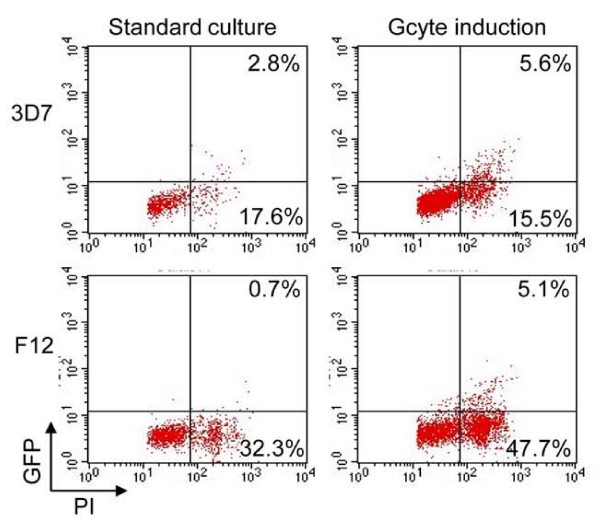
Culture conditions inducing sexual differentiation result in increased number of multinucleated-schizont stage parasites expressing Pfnek-4. Dot plots representations of GFP and propidium iodide (PI) fluorescence intensity of Pfnek-4-GFP 3D7 (upper panels) and F12 (lower panels) transfectants grown for four days either in standard culture conditions (low parasitaemia and every second-day dilution) or in conditions known to induce commitment to gametocytogenesis (high haematocrit blood cultures and high parasitaemia). Cells were fixed with 0.025% glutaraldehyde, stained for DNA with the fluorescent dye propidium iodide (PI) and subsequently analysed by a FACScan flow cytometer (Becton Dickinson). Uninfected red blood cells with low FL-2 (PI) fluorescence were excluded from the selection. Parasite numbers are given related to total number of infected red cells.